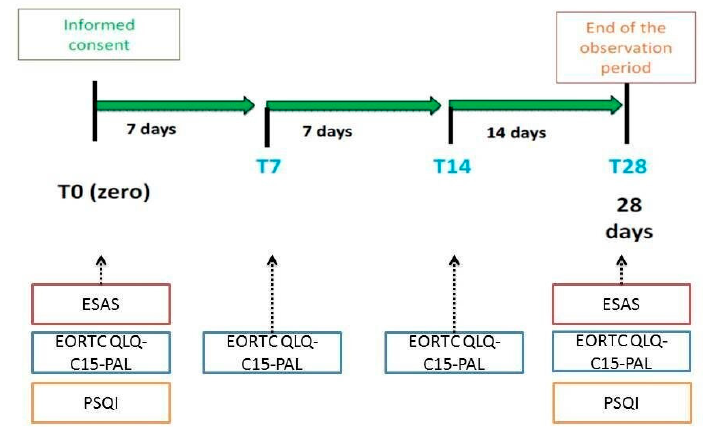
Figure 1. Study design. Legend: EORTC QLQ-C15-PAL, European Organization of Research and Treatment Quality of Life Questionnaire-Cancer 15; PSQI, Pittsburgh Sleep Quality Index; ESAS, Edmonton Symptom Assessment System.